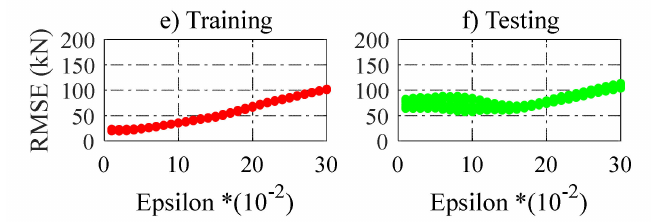
Figure 7. The performance of 210 SVM models.